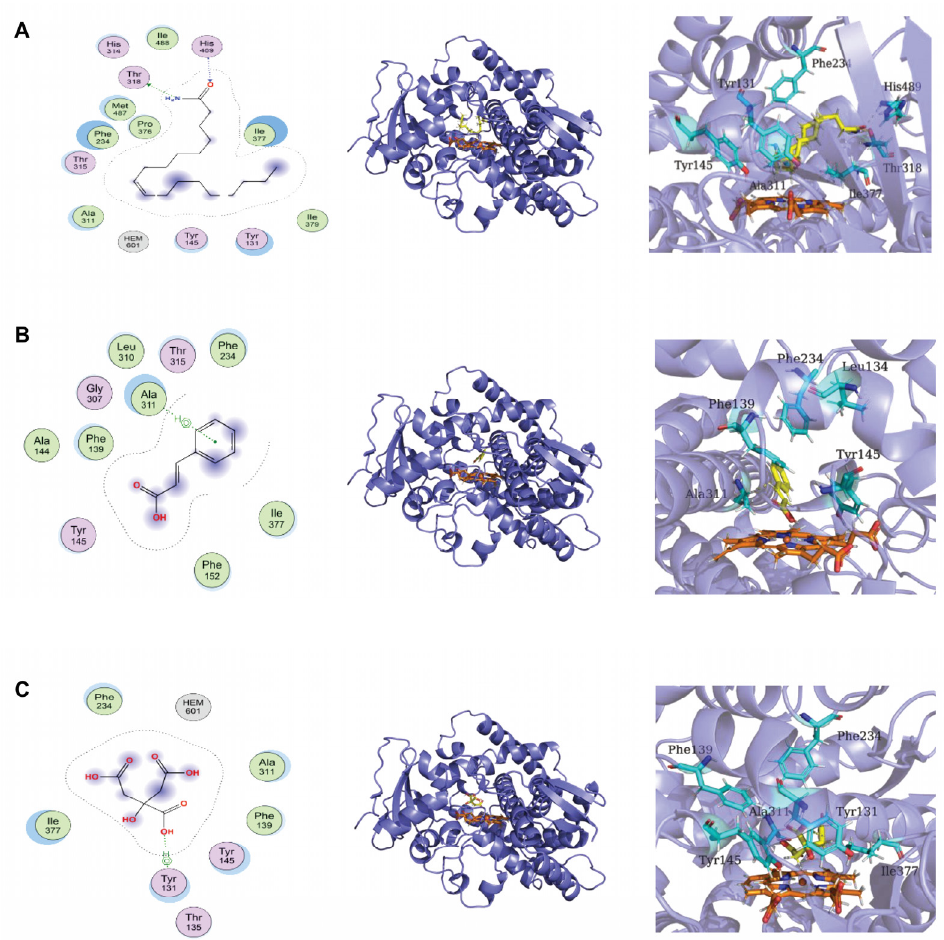
Figure 5. The molecular docking analysis of three metabolites produced by the Lactiplantibacillus plantarum LPP703 strain with lanosterol 14 α -demethylase (CYP51). ( A ) The 2D and 3D binding modes of CYP51 with oleamide. ( B ) The 2D and 3D binding modes of CYP51 with trans-cinnamic acid. ( C ) The 2D and 3D binding modes of CYP51 with citric acid.